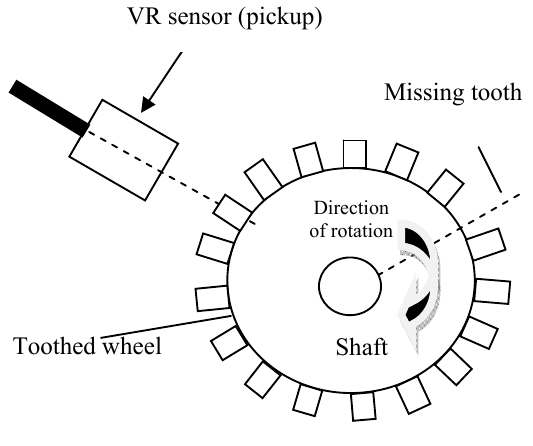
Figure 1. Variable Reluctance (VR) sensor that senses movement of the toothed wheel past point of